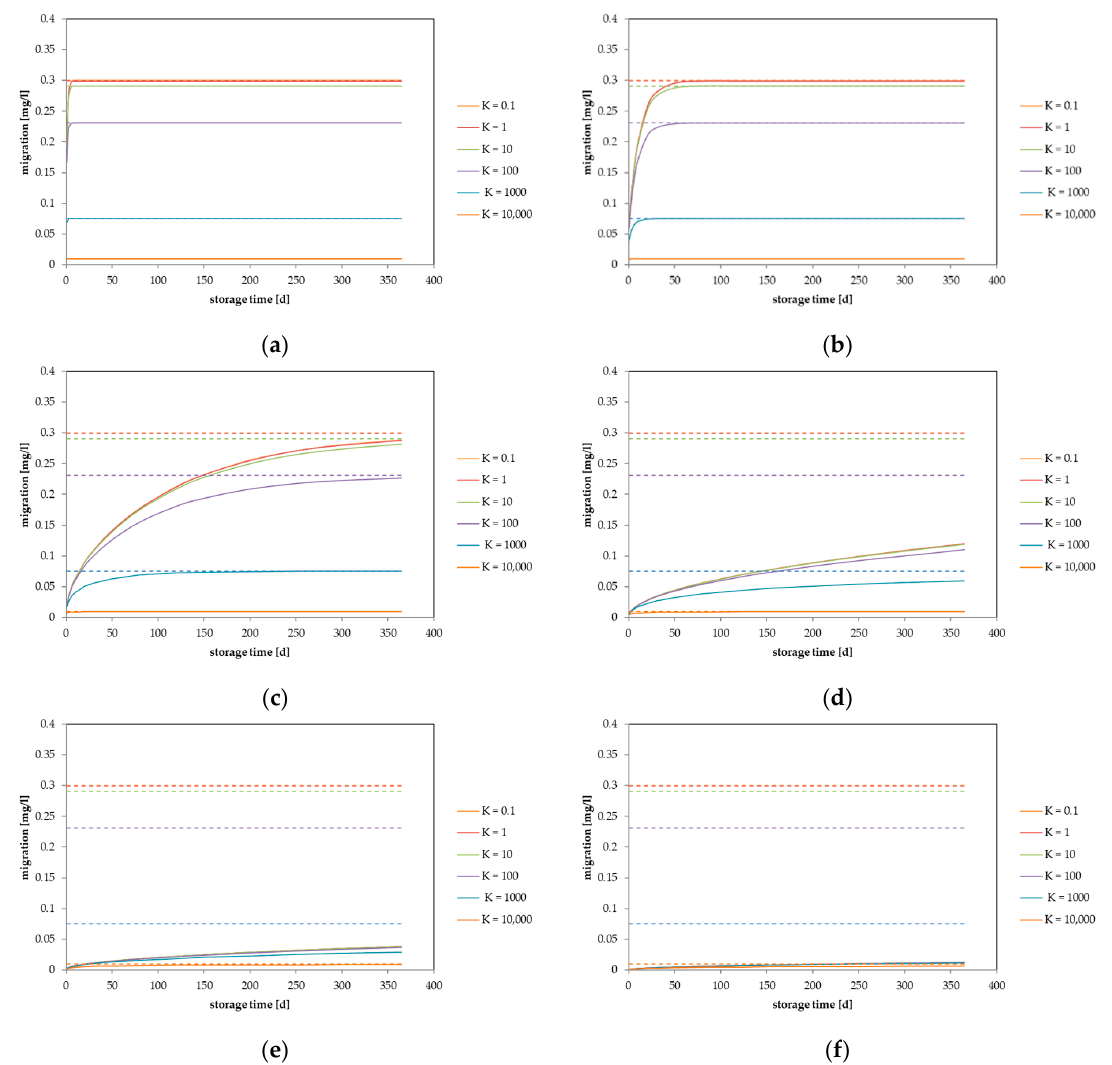
Figure 1. Calculated migration into food considering different partition coefficients: ( a ) diffusion coefficient D P = 1 × 10 − 10 cm 2 /s, ( b ) D P = 1 × 10 − 11 cm 2 /s, ( c ) D P = 1 × 10 − 12 cm 2 /s, ( d ) D P = 1 × 10 − 13 cm 2 /s, ( e ) D P = 1 × 10 − 14 cm 2 /s and ( f ) D P = 1 × 10 − 15 cm 2 /s. Calculated for a layer thickness of d = 50 µm, c P,0 = 100 mg/kg, V = 1000 mL, A = 600 cm 2 .